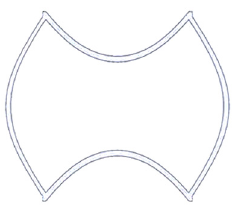
heads on both sides of the dynamic mold control system clamp the flexible NPR microstructure